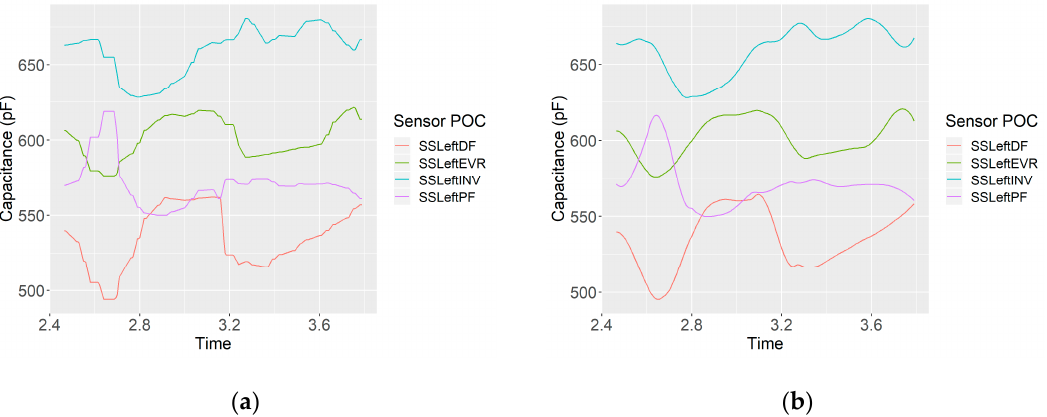
Figure 6. ( a ) Upsampled StretchSense™ gait cycle data for the left foot collected before filtering. ( b ) Upsampled StretchSense™ gait cycle data for the left foot after filtering (third-order, window length of 39).